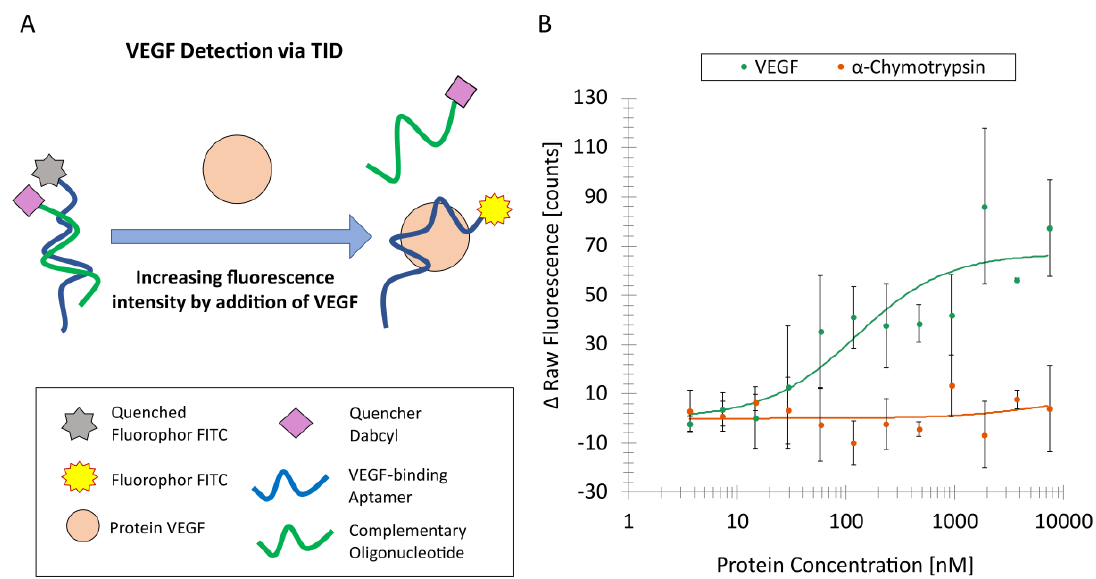
Figure3. V7t1aptamer-baseddetectionofVEGFbythetarget-induceddissociation(TID)ofcomplementary oligonucleotide via microscale thermophoresis (MST) capillary scan. ( A ) Schematic representation of VEGF detection by the TID of complementary oligonucleotide. VEGF replaces the quencher-modified complementary cV7t1-Dabcyl oligonucleotide, which leads to an increasing fluorescence intensity of the FITC-labeled V7t1 aptamer. ( B ) V7t1-FITC aptamer-based VEGF detection by the TID of complementary cV7t1-Dabcyl oligonucleotide via MST capillary scan. The fluorescence intensity depends on the VEGF concentration. Additionally, α -chymotrypsin was used as a negative